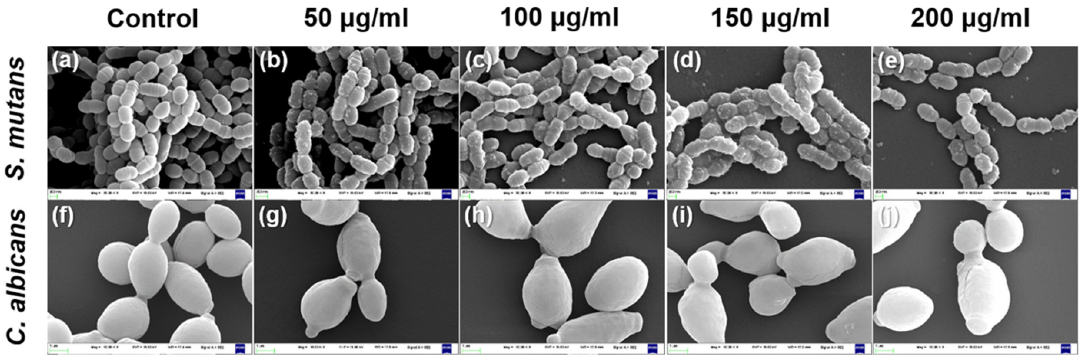
Figure 4. Field-emission scanning electron microscopy images of Streptococcus mutans and Candida albicans following ( a , f ) control and exposure to Glycyrrhiza uralensis extract with concentrations of ( b , g ) 50, ( c , h ) 100, ( d , i ) 150, and ( e , j ) 200 µg/mL. Upper 20,000×, lower 10,000×.